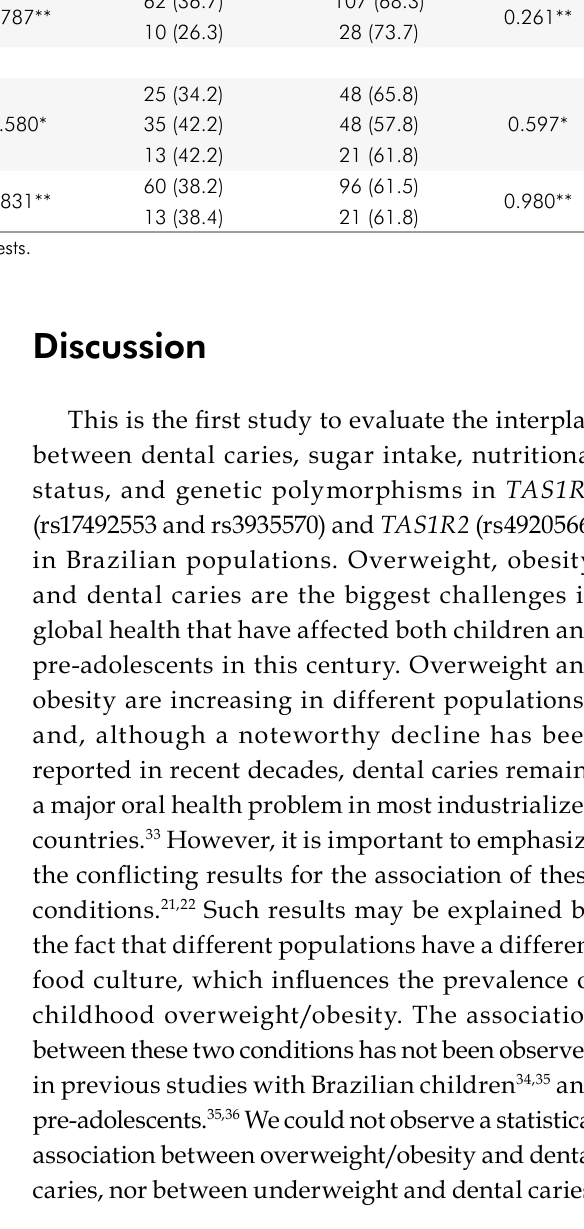
) for dental caries c